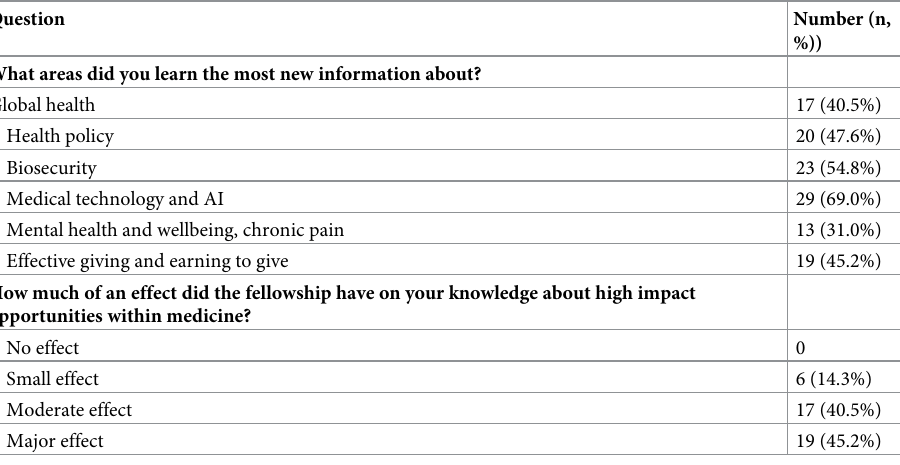
Table 5. Impact of fellowship on new information and knowledge gained.